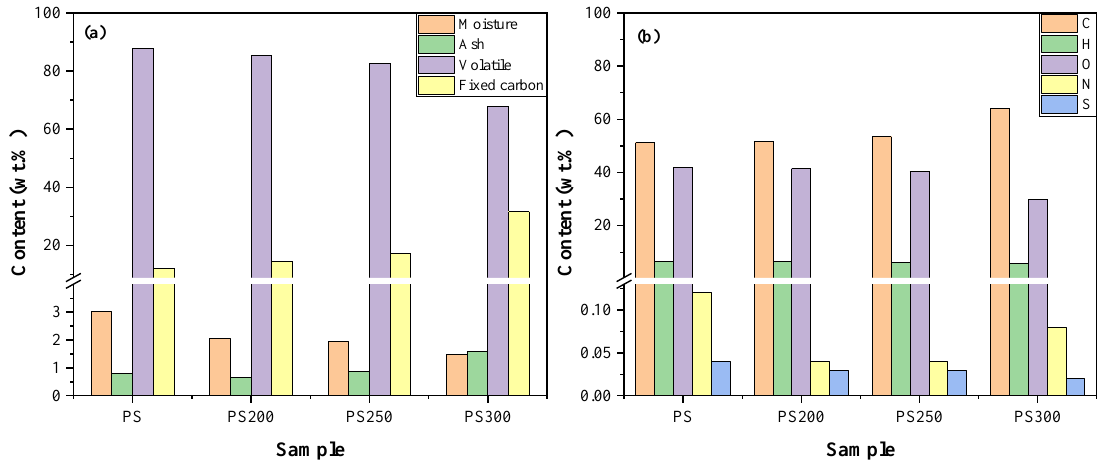
Figure 1. Proximate ( a ) and ultimate ( b ) analysis results.